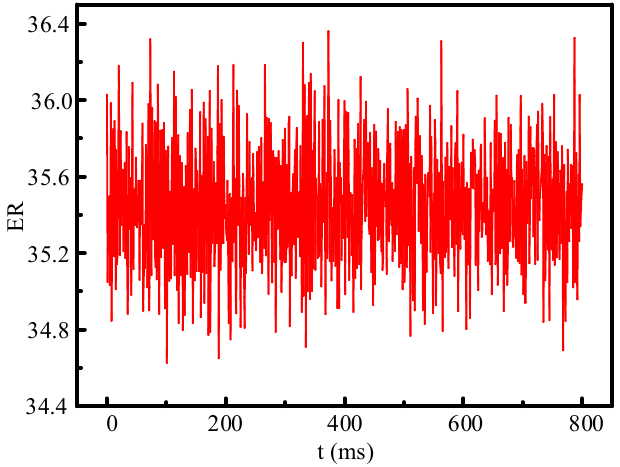
Figure 13. The correlation between pulsating and entrainment ratio (ER).